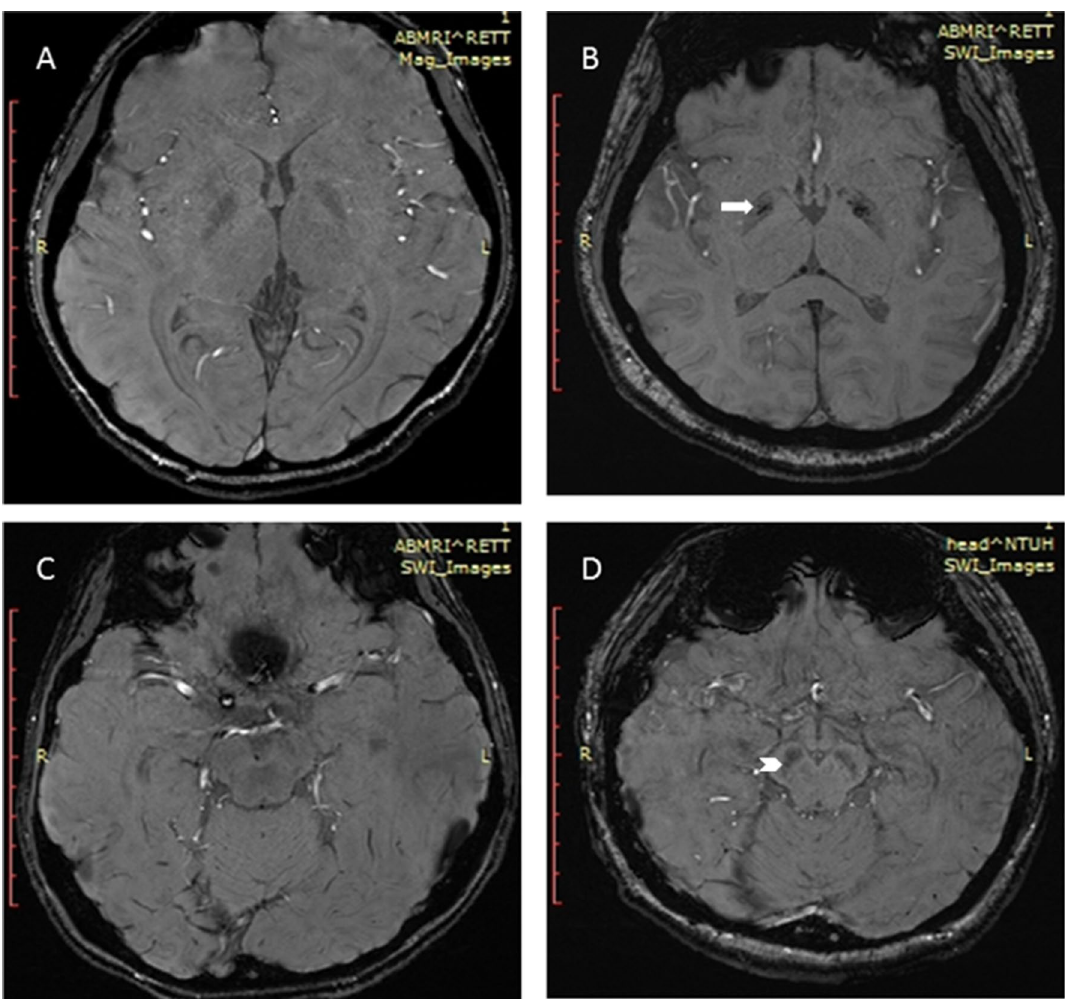
Figure 3. Susceptibility-weighted images in healthy control ( A , C ) and Rett syndrome patient ( B , D ) showing the relative hypointensity in globus pallidus ( B , arrow) and substantia nigra ( D , arrowhead) in Rett